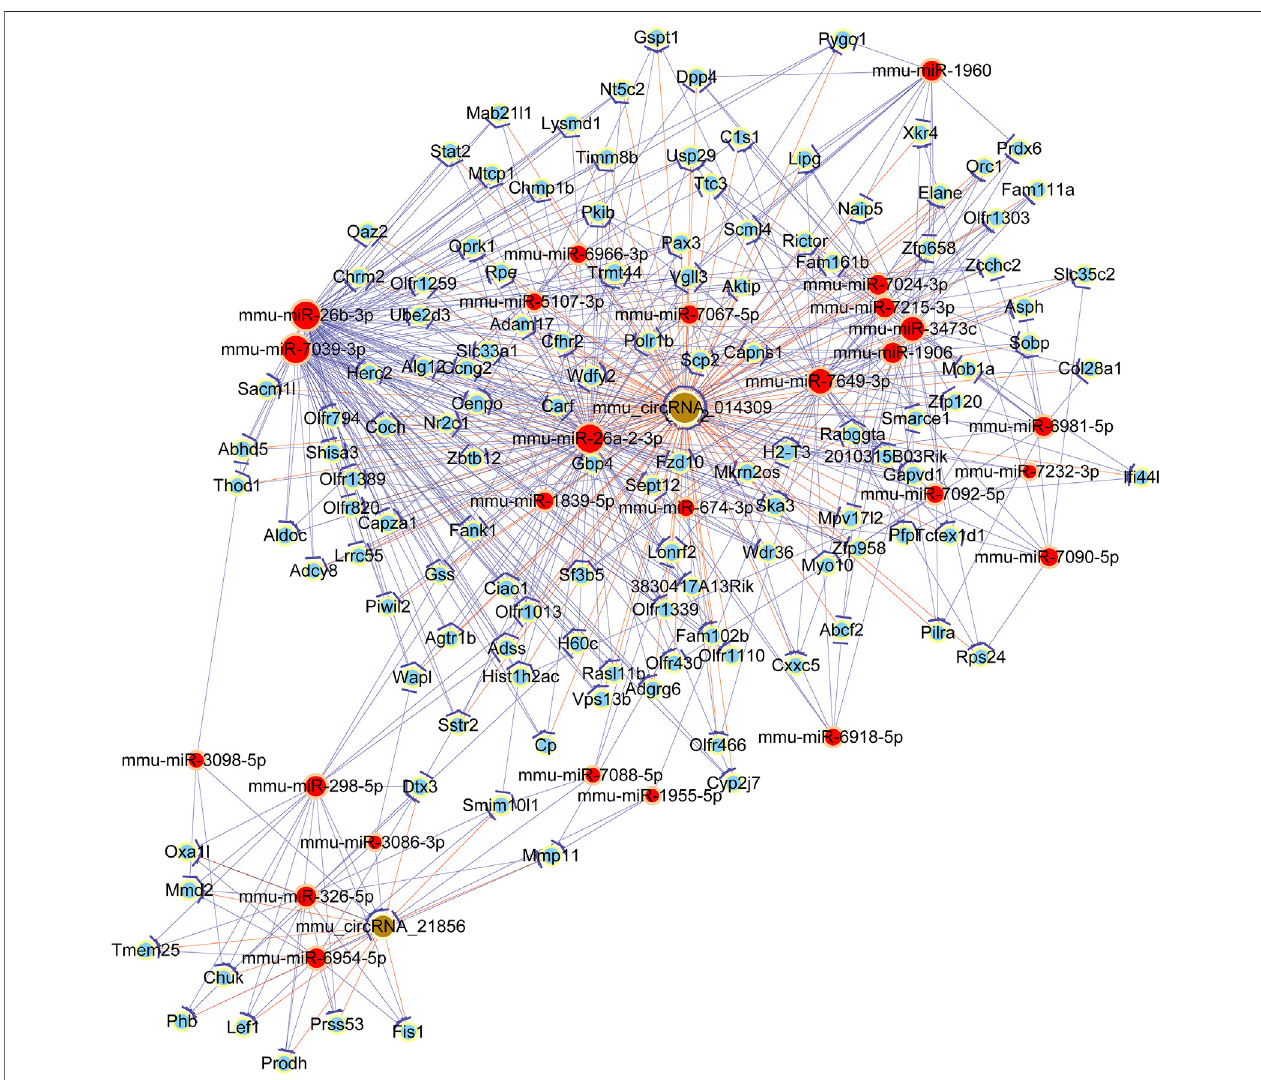
FIGURE 5 | Establishment of circRNA-miRNA-mRNA network for two candidate circRNAs.